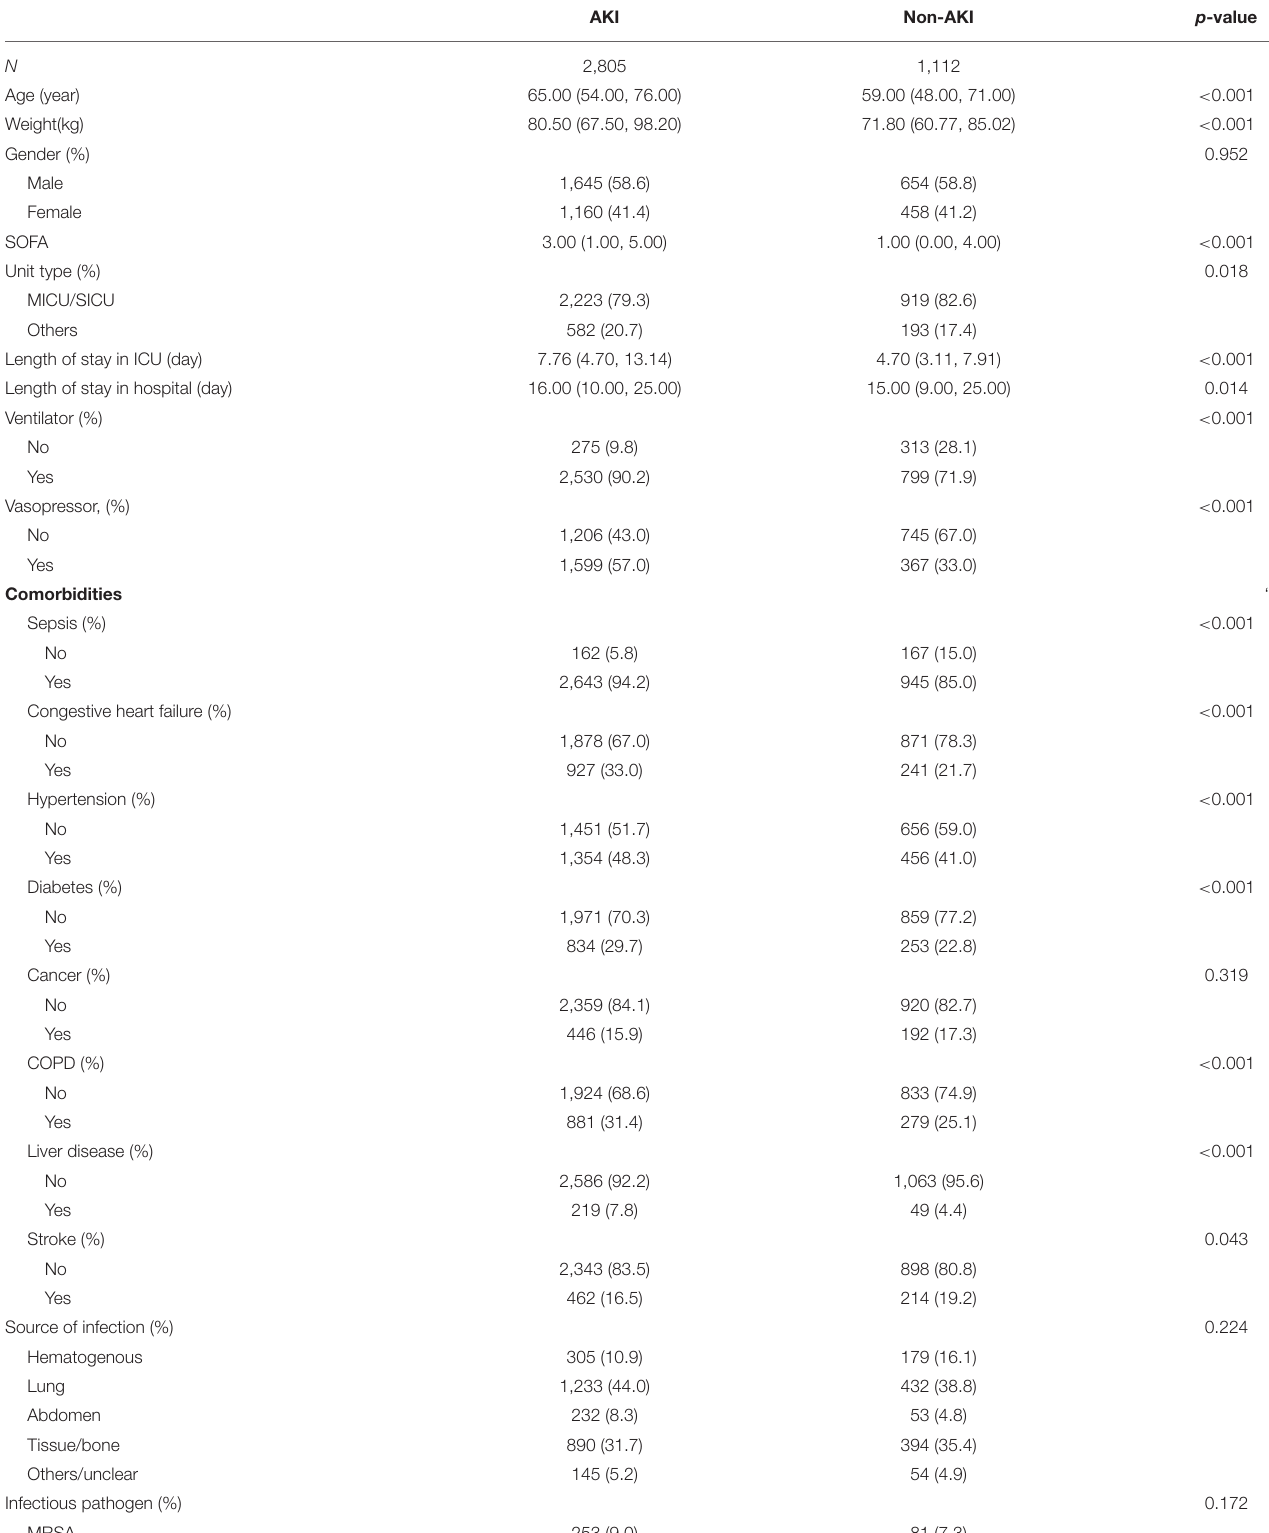
TABLE 1 | Baseline characteristics of the study